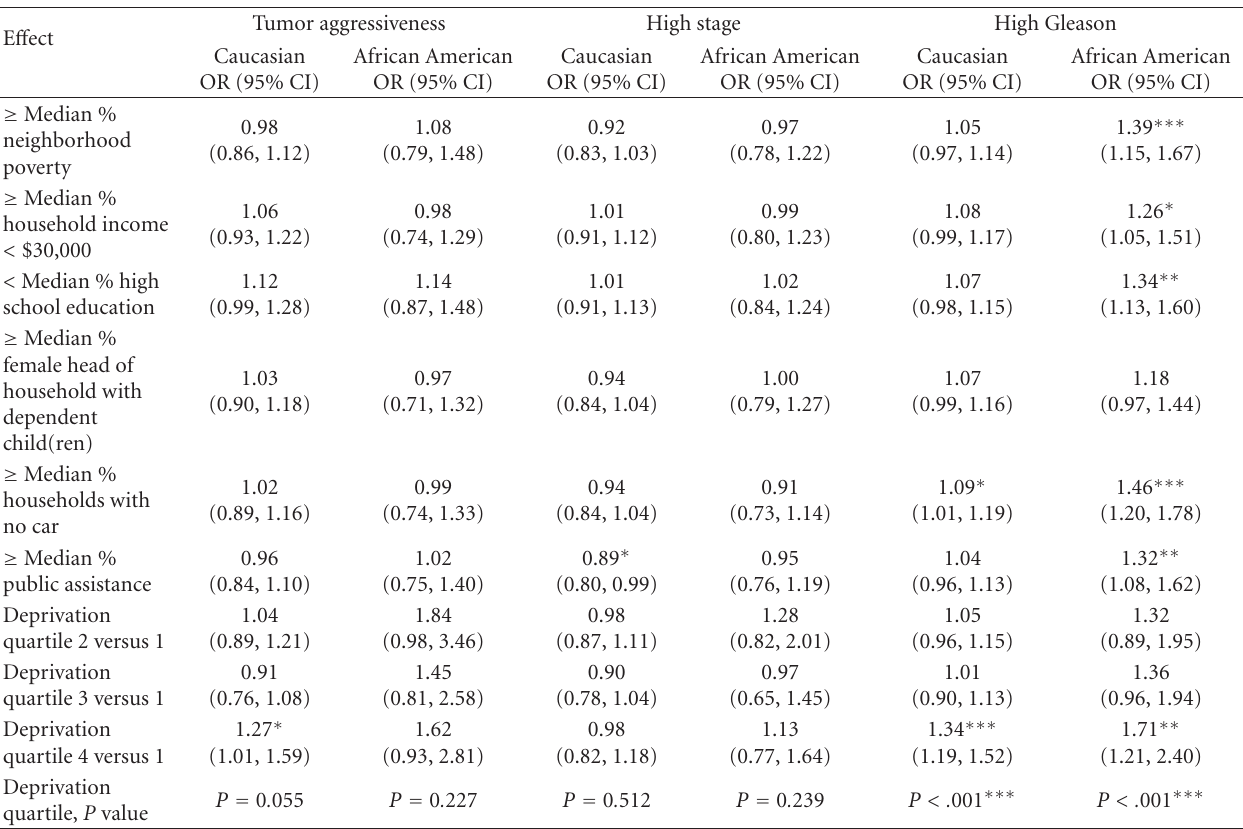
Table 2: Stratified analysis—associations of neighborhood SES characteristics with indicators of prostate cancer severity (GEE) adjusted for age and diagnosis